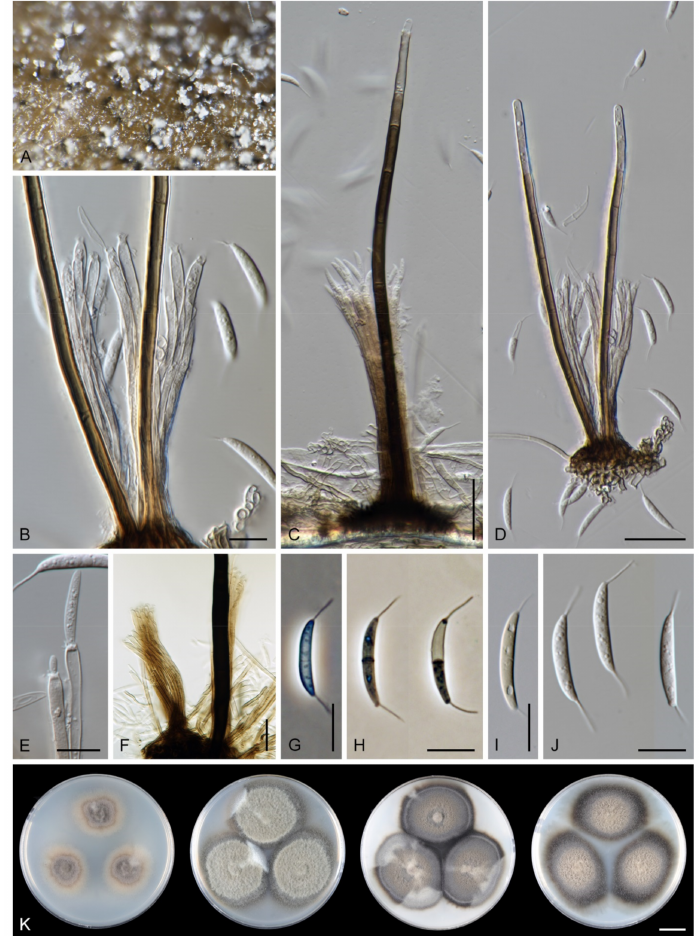
Figure 2. Arcuatospora novae-zelandiae . ( A ) colony on CMA with Urtica stems ( B ) synnemata around the setae, in detail ( C, D ) Setae with unilateral synnemata ( E ) conidiogenous cells ( F ) synnemata growing with and without setae ( G – J ) conidia ( K ) colonies on CMD, MLA, OA and PCA after 4 weeks (from left to right). Images: ( A – E , J ) CBS 109476; ( F – I , K ) CBS 109475; ( A – K ) on CMA with Urtica stems after 4 weeks. Scale bars: ( B , E , G – J ) 10 µ m; ( C , D , F ) 20 µ m; ( K ) 1